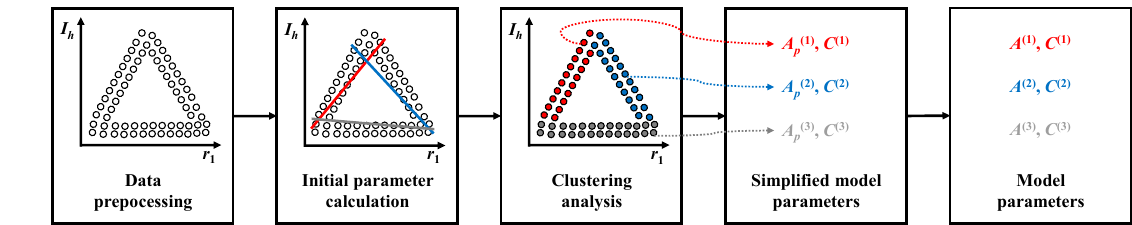
Figure 1. The process of the proposed data-driven compartmental modeling method (DCMM).